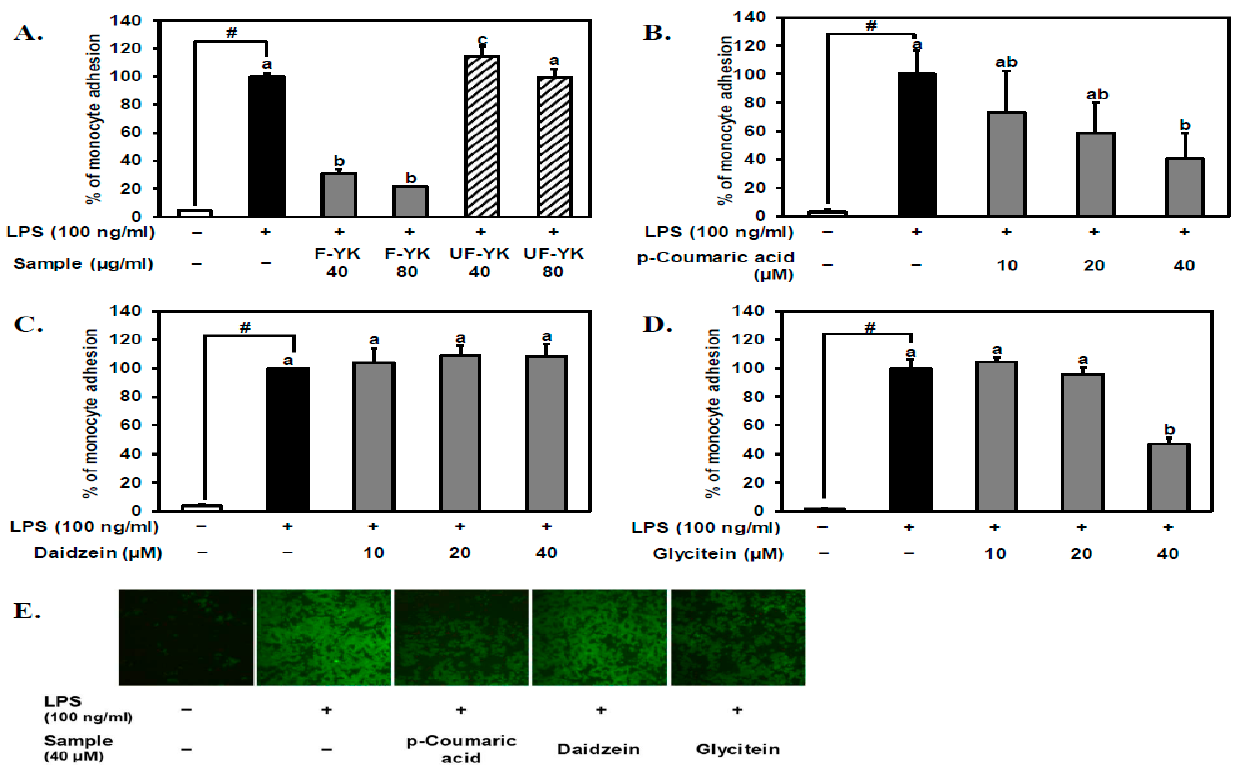
Figure 3. Effect of fermented YK extract and its bioactive compound p-coumaric acid on lipopolysaccharide (LPS)-stimulated THP-1 monocyte–endothelial cell adhesion. After pretreatment with ( A ) unfermented, fermented YK extract, ( B ) p-coumaric acid, ( C ) daidzein, and ( D ) glycitein at various concentrations for 1 h, human umbilical vein endothelial cells (HUVECs) were induced by LPS for 5 h. ( E ) Representative images of THP-1 monocyte–endothelial cell adhesion with 40 µM of p-coumaric acid, daidzein, and glycitein. Calcein AM-labeled THP-1 monocytes were added to HUVECs for 1 h and washed with phosphate-buffered saline (PBS). Quantification of adhered THP-1 cells was conducted as described in the Materials and Methods. Data from A to D are expressed as mean ± SD ( n = 3). Student’s t -test was used for statistical analysis between control and LPS treatment; # ( p < 0.05). Data were analyzed using one-way analysis of variance (ANOVA) followed by Tukey’s honest significant difference test. Different letters (a, b, and c) on the top of the bars indicate significant differences ( p < 0.05) among sample treatments with LPS. UF-YK, unfermented Yak-Kong extract; F-YK, Yak-Kong extract fermented with P. pentosaceus AOA2017; +, treated with LPS or samples, − , not treated with LPS or samples.